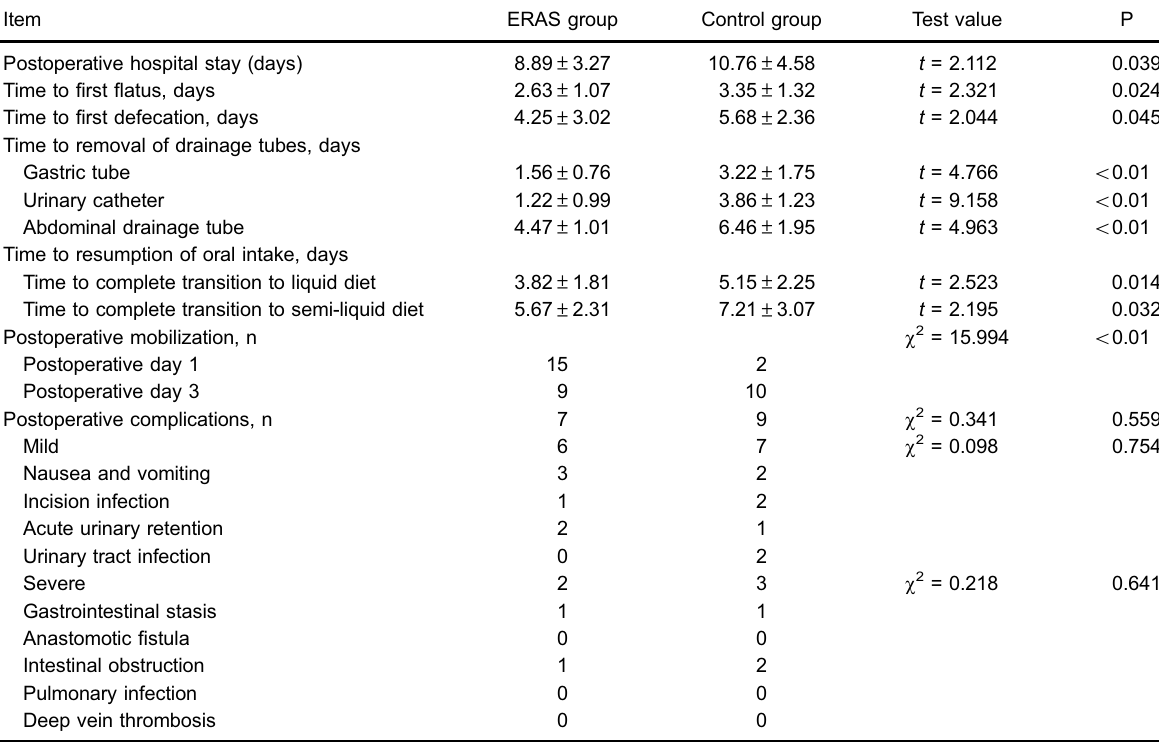
Table 3. Comparison of postoperative clinical course between the two groups of patients.